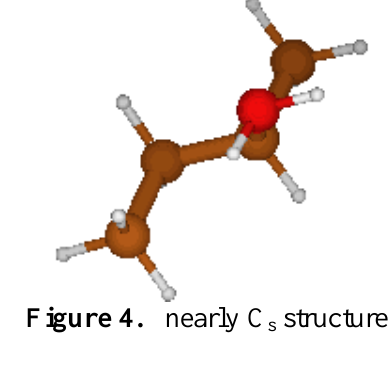
Figure 4. nearly C